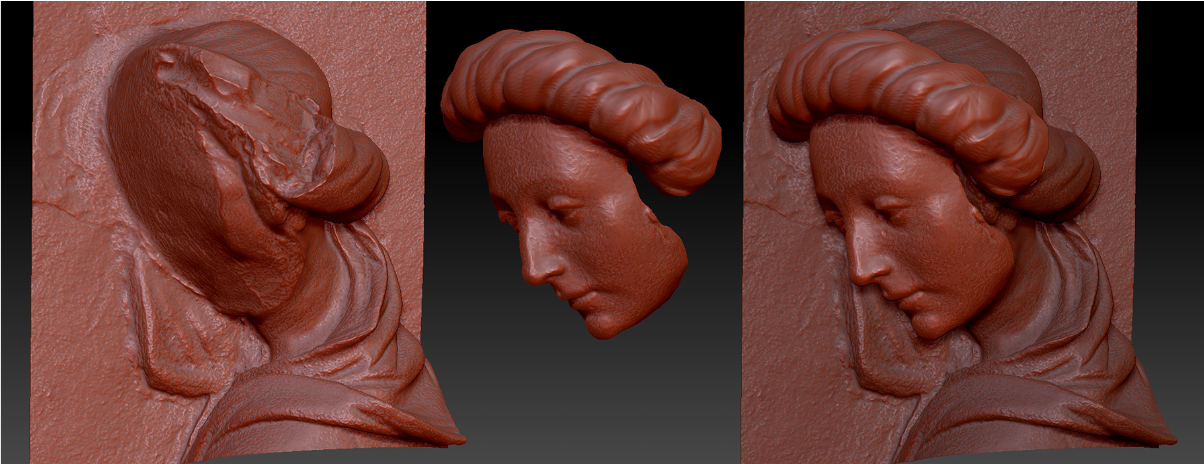
Figue 7. Virtual restoration: mesh model of the female figure whose face has been lost (left), the reconstructiond hypotesis based on surviving elements and antropometric data (centre), the virtual integration of both models